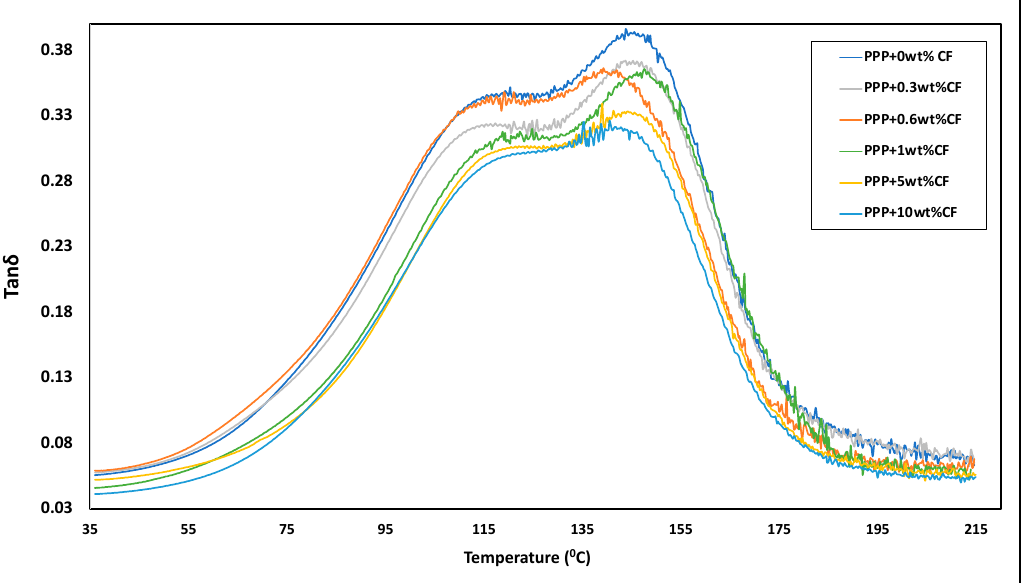
Figure 9. DMA test result of PPP/CF composites; effect of CF content in SLS-Printed fully cured thermose tt ing samples on damping factor.